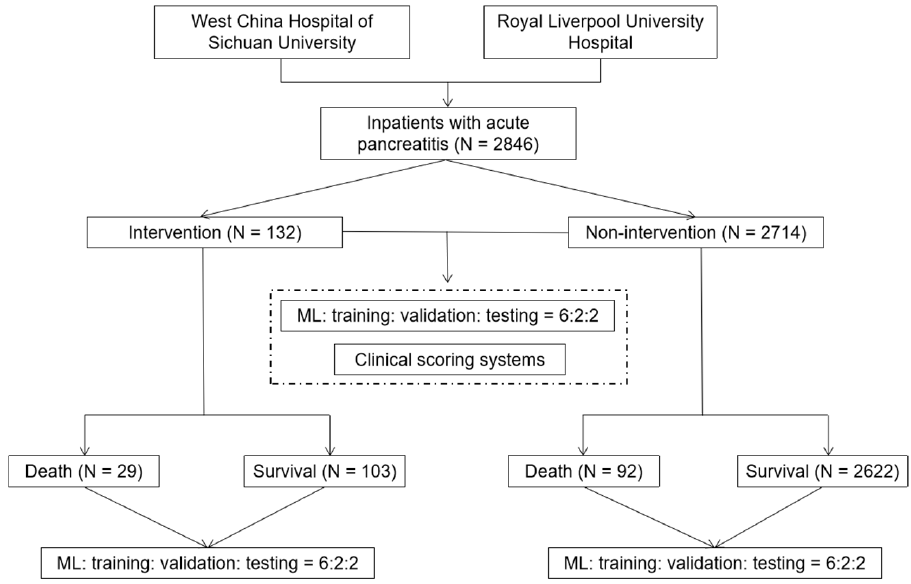
Figure 1. The flow chart of this